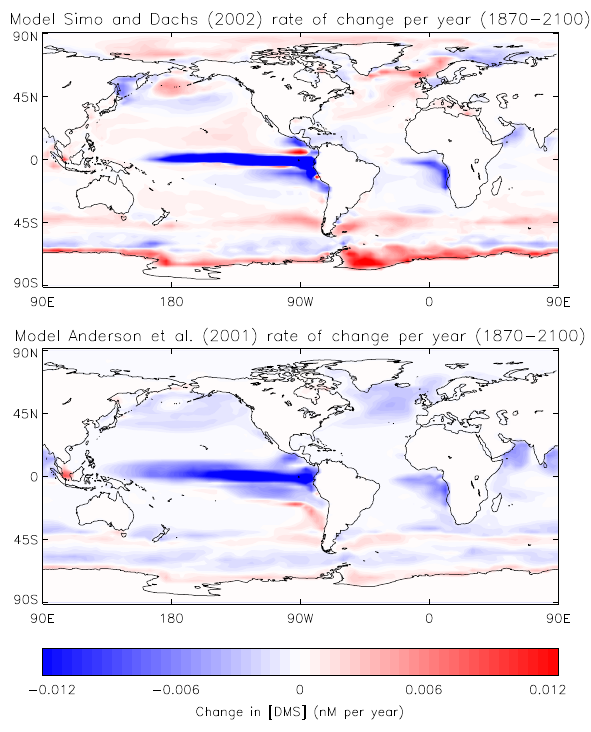
Fig. 5. Mean annual change in surface water [DMS] calculated using (a) the Simo (2002) and (b) Anderson (2001) parameterisations from fields produced by existing 20 th and 21 st century climate runs (following the IPCC’s SRES 2a scenario) using the Met Office Hadley Centre’s model HadCM3, with the HadOCC biogeochemi- cal model (containing only a single phytoplankton group). Colours represent the gradient of a least squares regression through monthly mean data for each grid-point over the period 1870 to